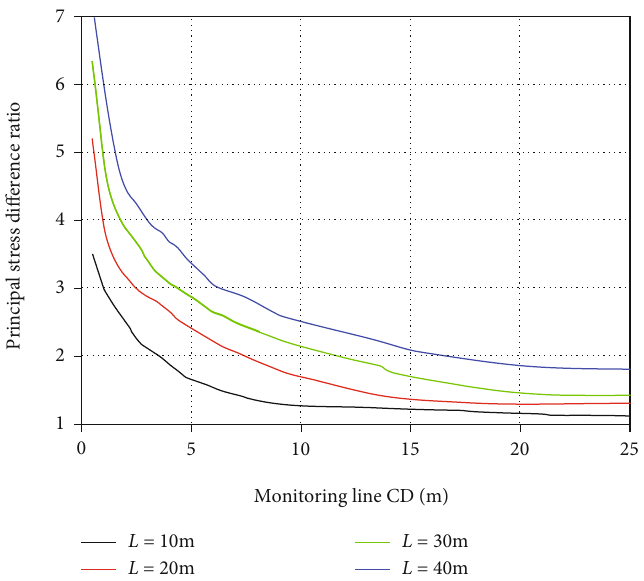
Figure 5: Variation trend of principal stress di ff erence ratio in monitoring line C-D.